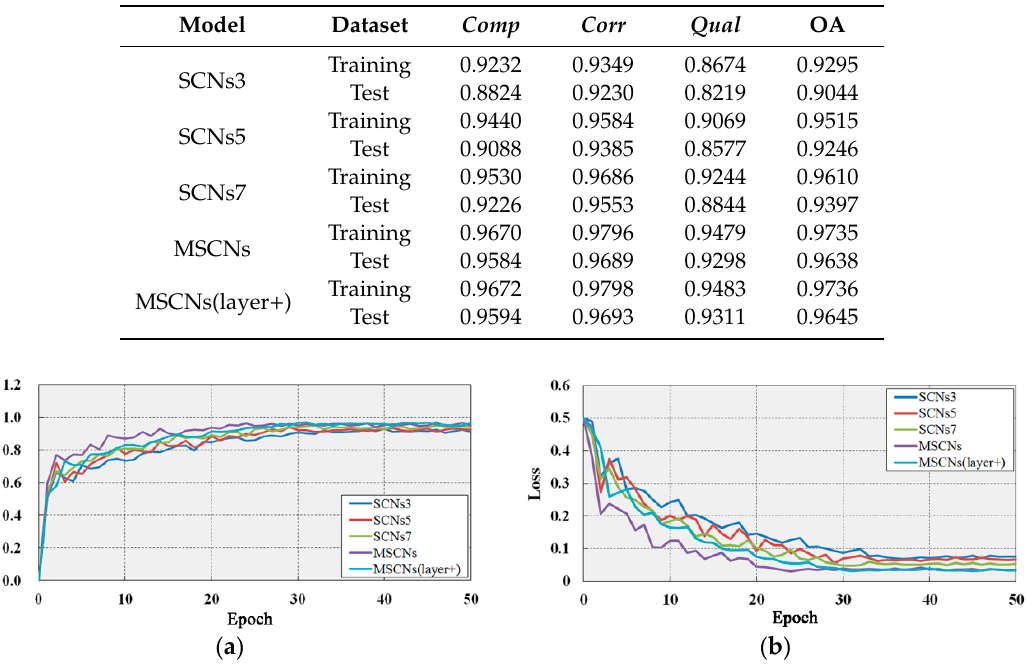
Figure 14. Plots showing the OA ( a ) and loss ( b ) of SCNs3, SCNs5, SCNs7, MSCNs, and MSCNs(layer + ) in the training epochs.